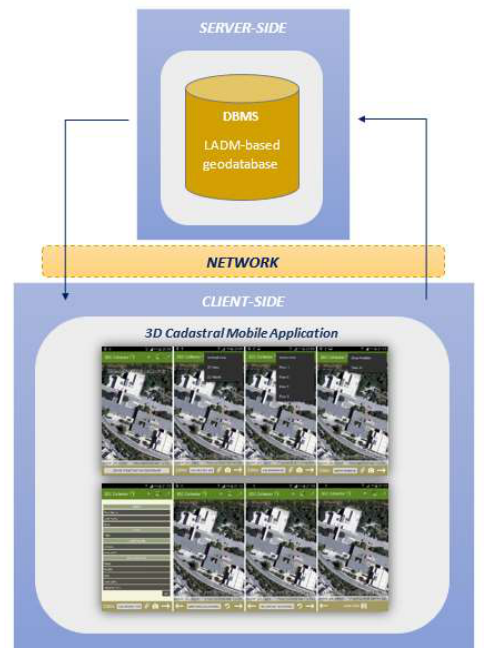
Figure 1. Architecture diagram of the 3D cadastre technical framework